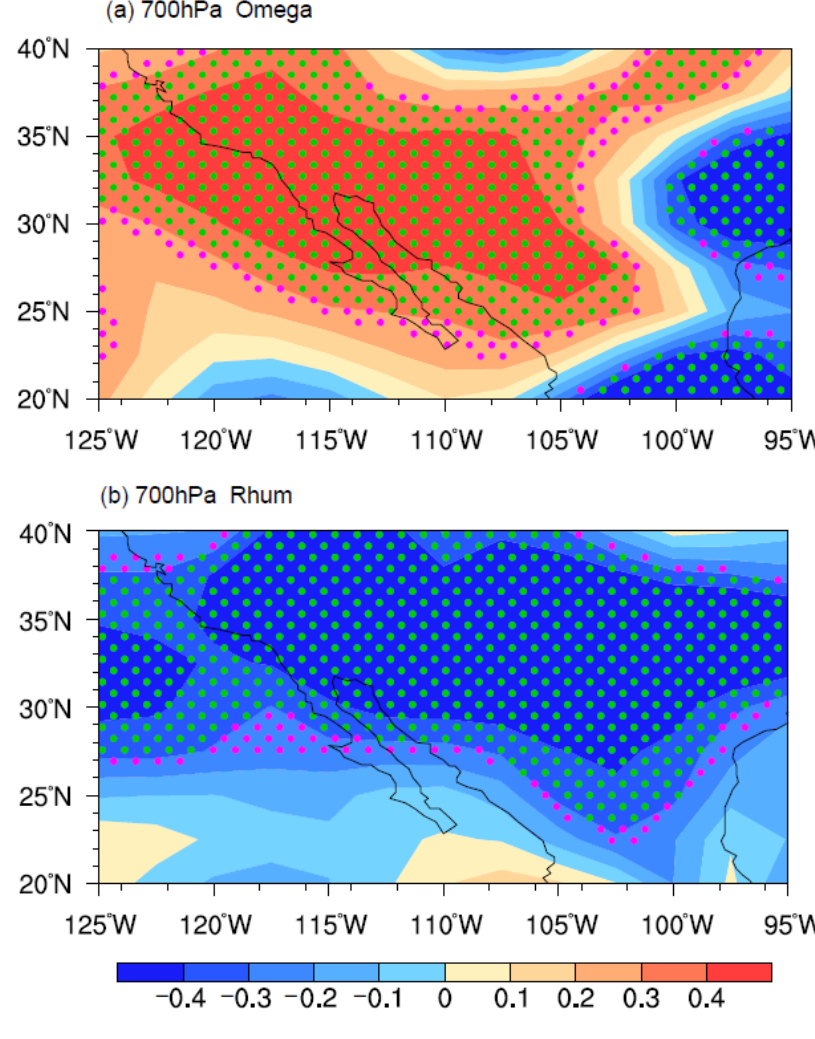
Figure 10. Partial correlation maps between the winter local geopotential height index (HGTI) and winter ( a ) vertical velocity and ( b ) relative humidity at 700 hPa without the ENSO signal. The magenta and green stippled areas indicate statistical significance at the 90% and 95% confidence levels, respectively.